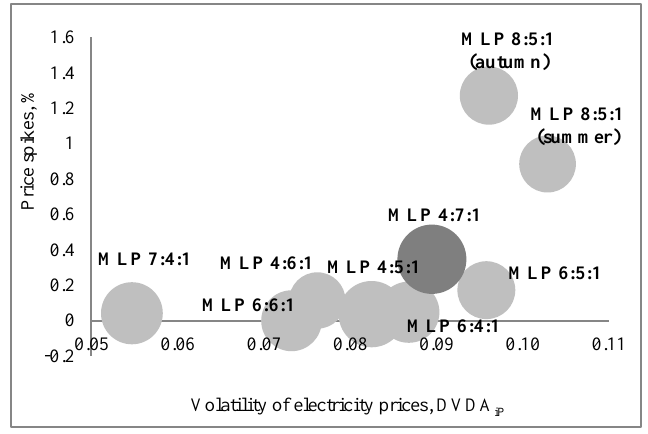
Fig. 7. The relationship between volatility, price spikes and accuracy of the models (made by the